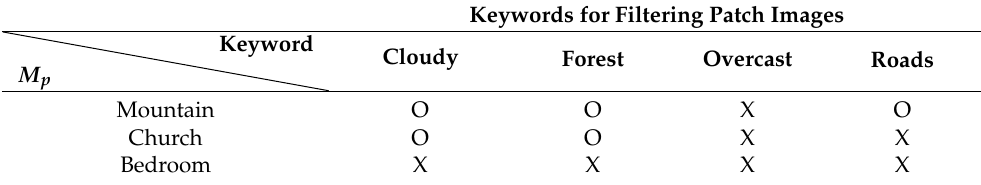
Table 3. Subjective evaluation of the quality of the synthesized view on different pre-trained models in Figure 5. The “X” shows that the model did not retain the original structure. The “O” shows that the model kept the original structure of the reference